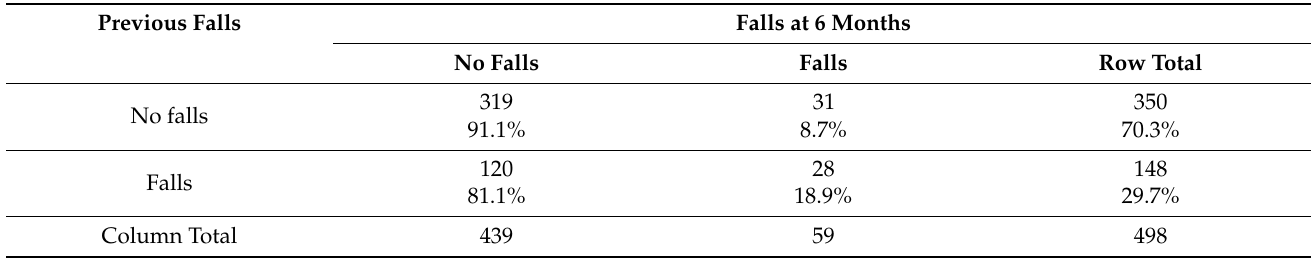
Table 1. Difference in falls at 6 months in relation to the existence of previous falls *.